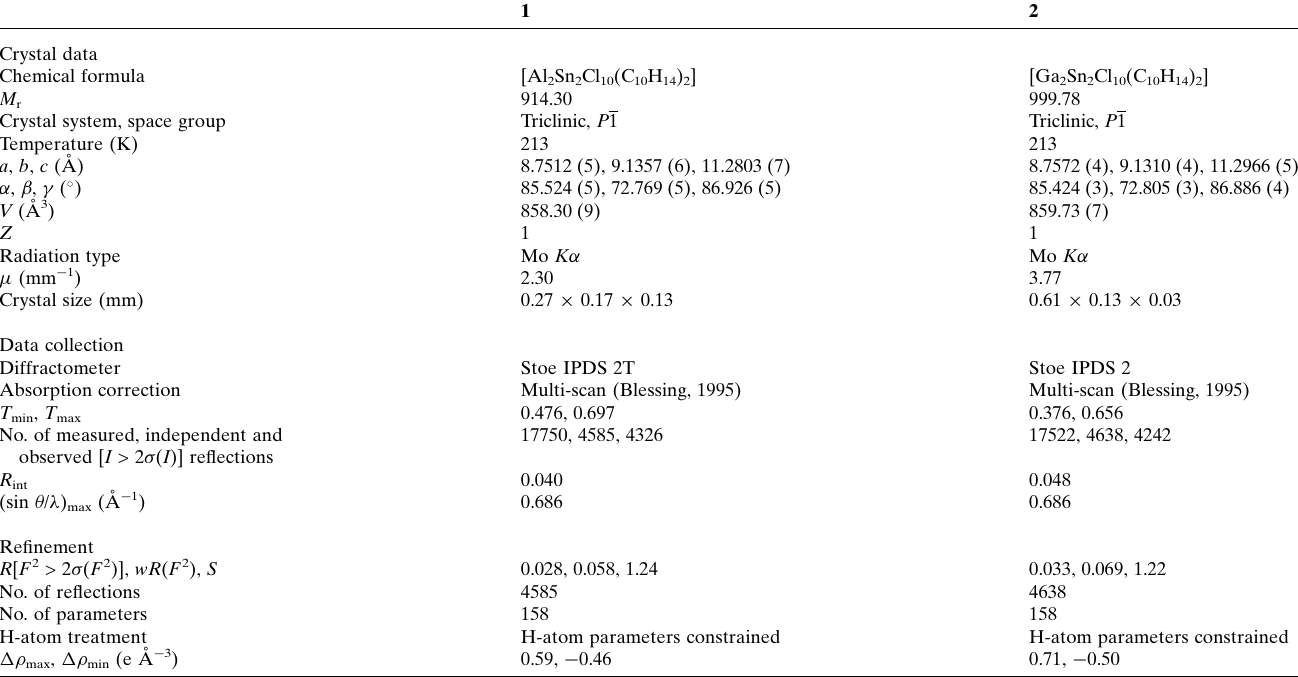
Crystal data Chemical